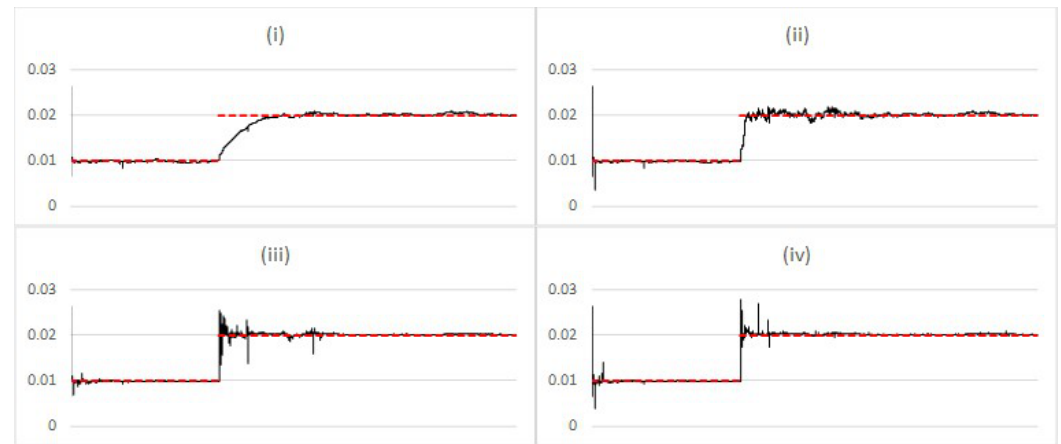
Figure 8. Comparing estimated posterior expected value (black) vs. simulation input value (red) of σ with regime change after 10,000 steps, using the Liu and West filter with learning for different values of γ ( i ) 0.0001; ( ii ) 0.001; ( iii ) 0.01; ( iv ) 0.1.